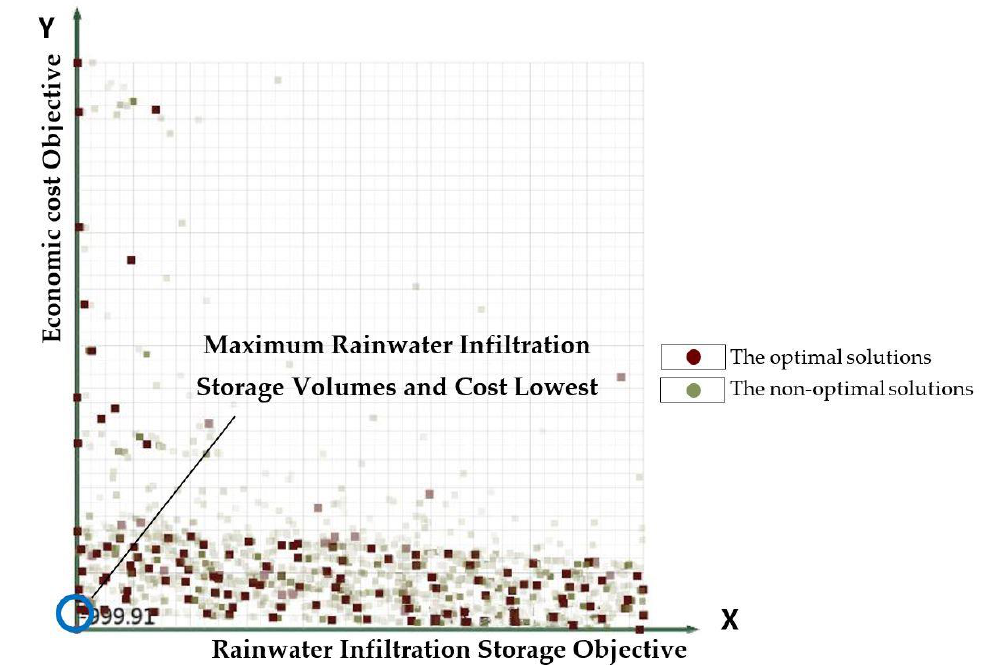
Figure 9. Rainwater infiltration and storage and economic objective are both optimal.